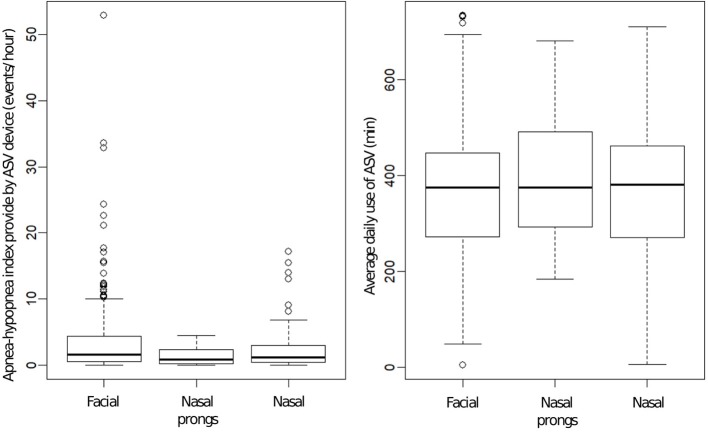
(Left) Box plots of apnea-hypopnea index (AHI) provided by ventilator software according to interface used (data were available for 428 patients, missing for 30). Differences were statistically significant (p = 0.012) but not clinically relevant. Bold line is median value; box defines 25th and 75th centiles. (Right) Box plots of average daily use of adaptive servo-ventilation according to interface used (data available for 419 patients, missing for 39). Values for daily use and AHI were average values over 90 days (median = 90; IQR: [32; 182]).